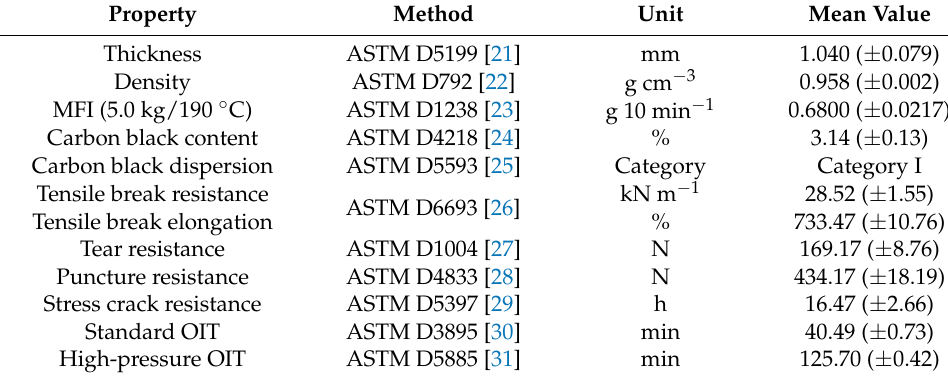
Table 1. Initial values of high-density polyethylene geomembrane’s